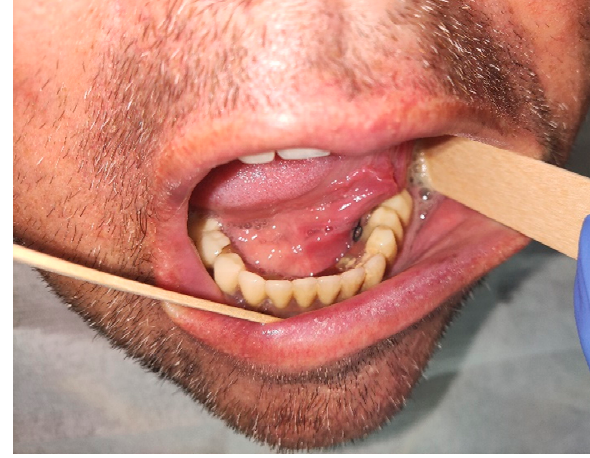
Figure 7. Seven days after operation, medical examination and removal of sutures.